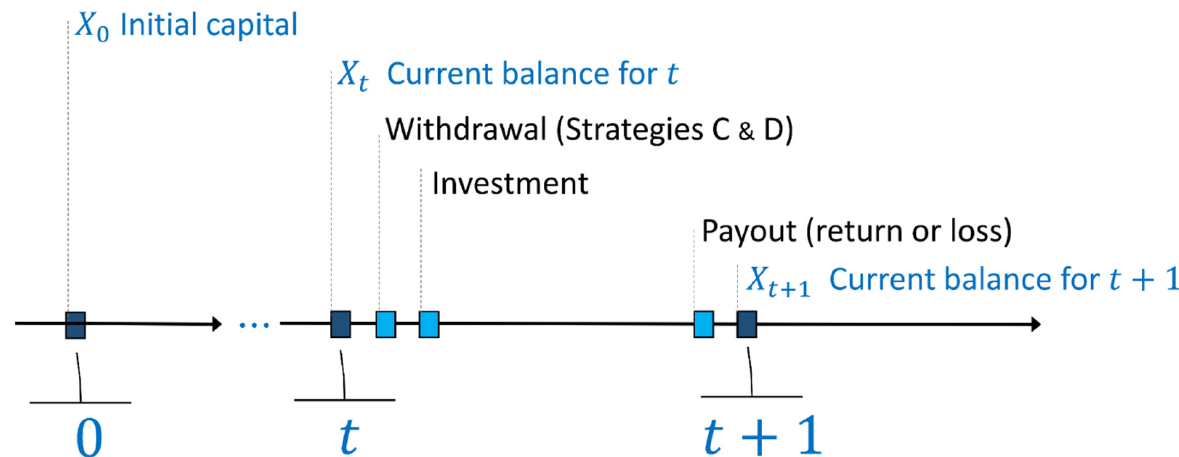
Figure 3. Order of events in each period assumed in the research study.